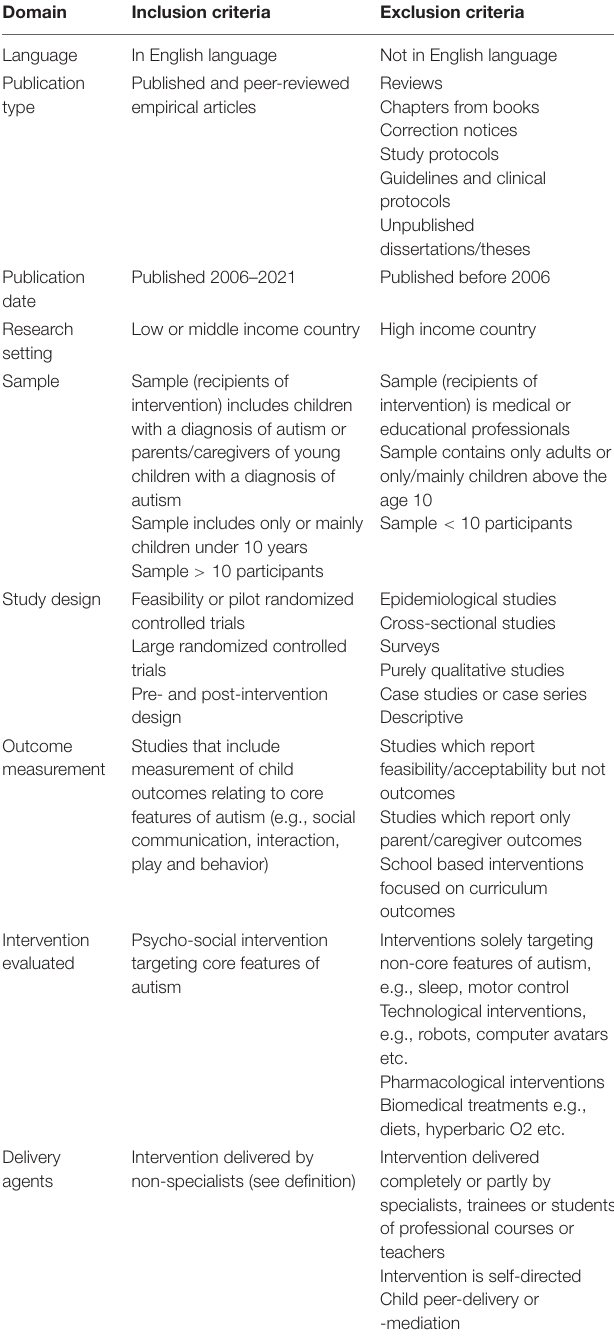
TABLE 2 | Inclusion/exclusion